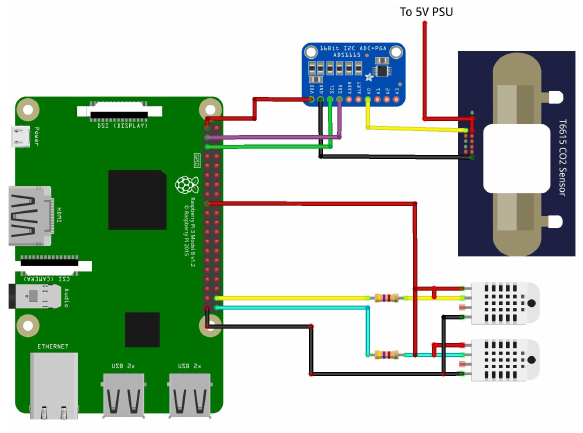
Figure 6. Schematic of electrical connections for T6615 CO 2 sensor and the DHT22 temperature/ humidity sensors. The carbon dioxide sensor is powered by an external power supply unit since it has a current consumption which is not manageable from the Raspberry Pi GPIO. The output of the CO 2 sensor is an analog signal which is acquired by the ADS 1115